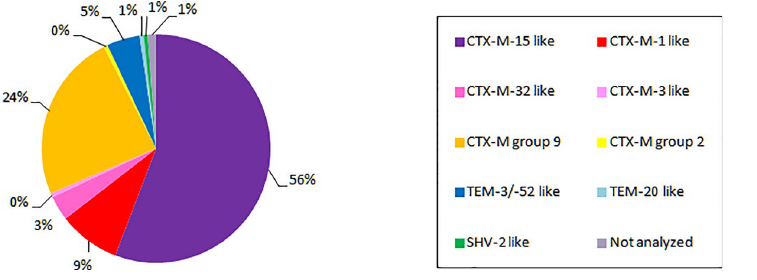
Fig 1. Distribution of ESBL-producing Enterobacteriaceae by type of enzyme (n = 172 isolates). https://doi.org/10.1371/journal.pone.0214327.g001 ESBL coding genes belonged to the CTX-M family (93.0%) with a predominance of CTX-M